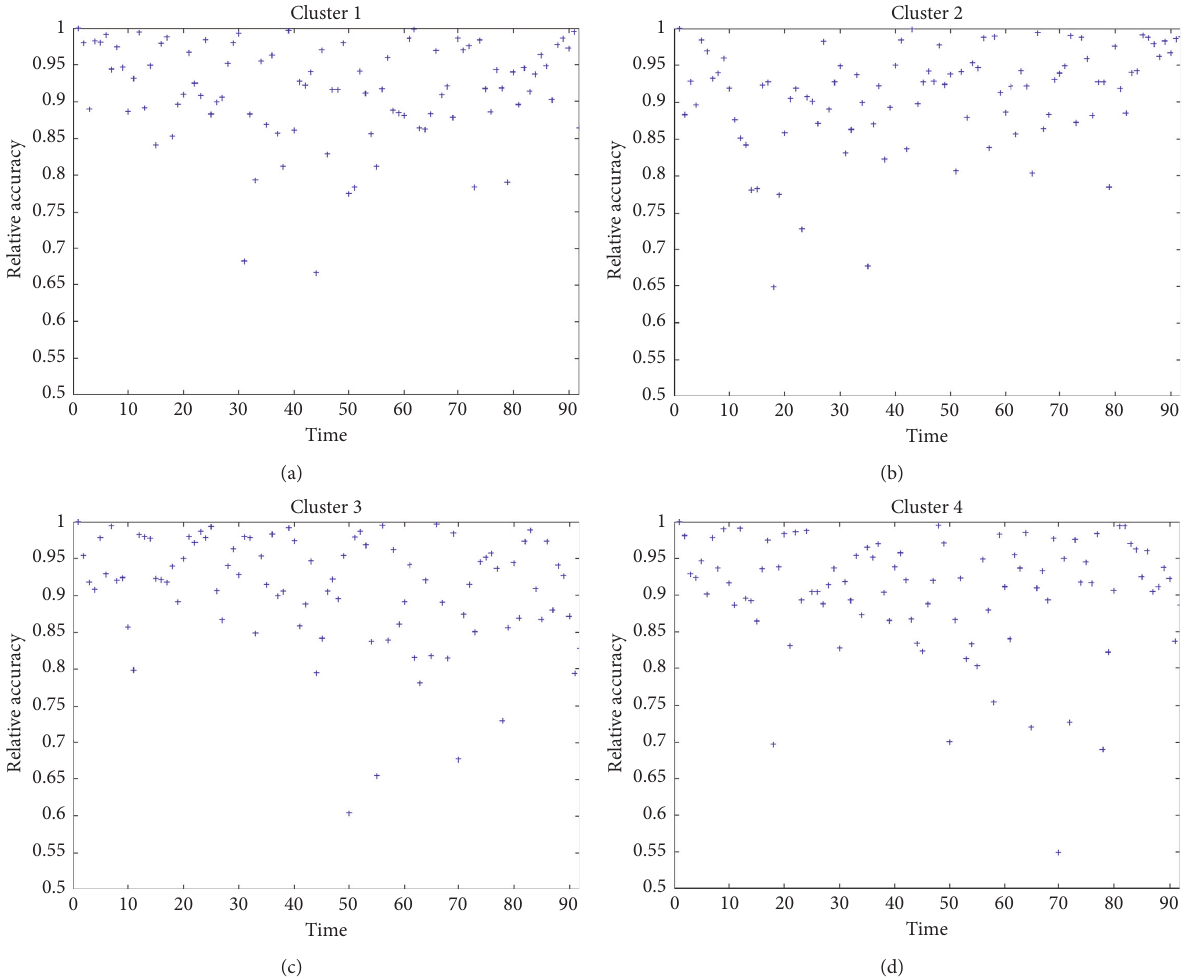
Figure 8: The accuracy of each cluster (city region) from July 1, 2020, to September 30, 2020, based on the accuracy definition of MRA. The MRA of each cluster is: (a) Cluster1: 0.916204425; (b) Cluster2: 0.909559991; (c) Cluster3: 0.909098728; (d) Cluster4: 0.904568447. And the MRA of the entire study area is 0.90985790.